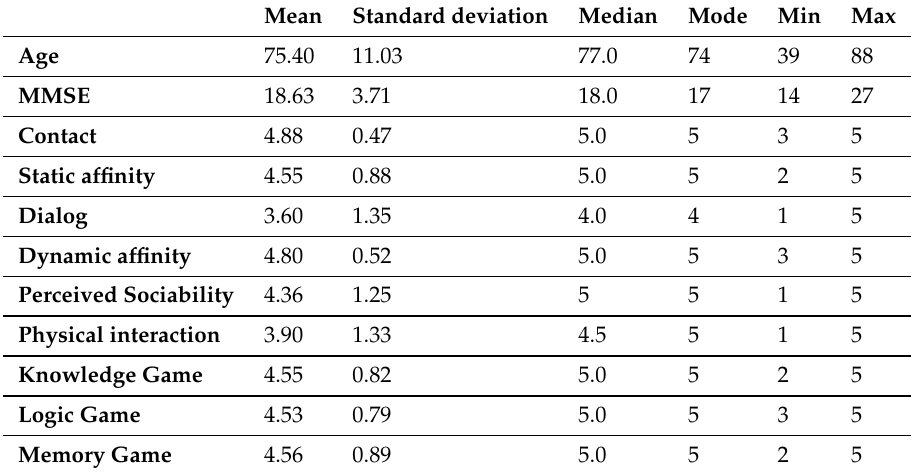
Figure 8. Result of the obtained scored in the test. Table 3. Statistical results of the